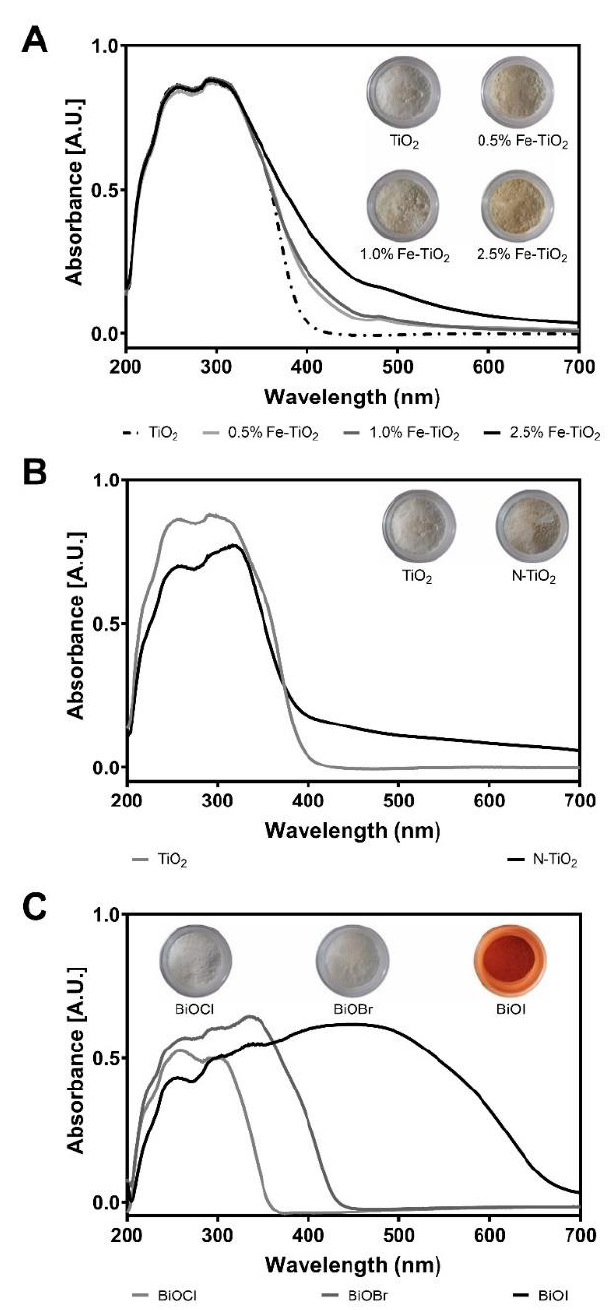
Figure 1. Diffuse reflectance spectra of titanium dioxide and bismuth oxyhalide photocatalysts: ( A ) iron-doped titanium dioxide, ( B ) nitrogen-doped titanium dioxide, and ( C ) bismuth oxyhalide photocatalysts. Insets show pictures of photocatalyst samples.